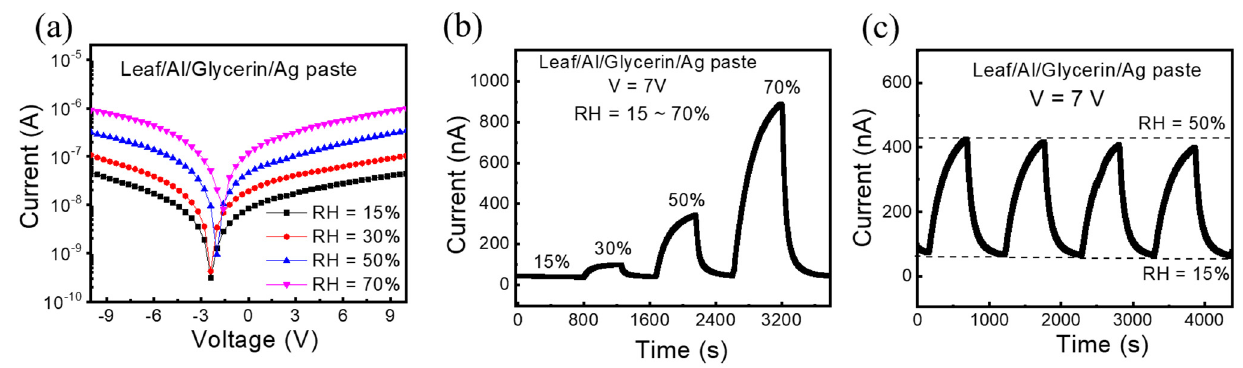
Figure 3. Electrical properties of humidity sensor. ( a ) I–V curve under different humidity. ( b ) Real − time current measurement at different humidity conditions. ( c ) repeatability test of the sensor under RH = 50% (V = 7 V).